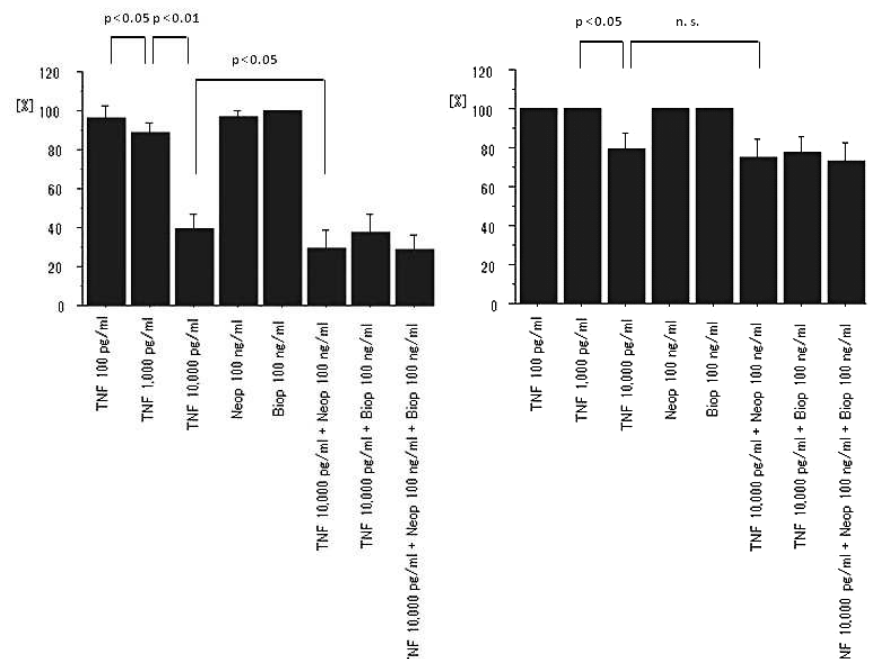
Figure 1: In vitro results of viability assay MTT. Graphs show survival rates (in percent of baseline) of mononu- clear cells (MNs; left columns) and PMNs polymorphonuclear cells (PMNs; right columns), TNF = tumor necro- sis factor- a , Neop = neopterin, Biop = biopterin, n.s. = not